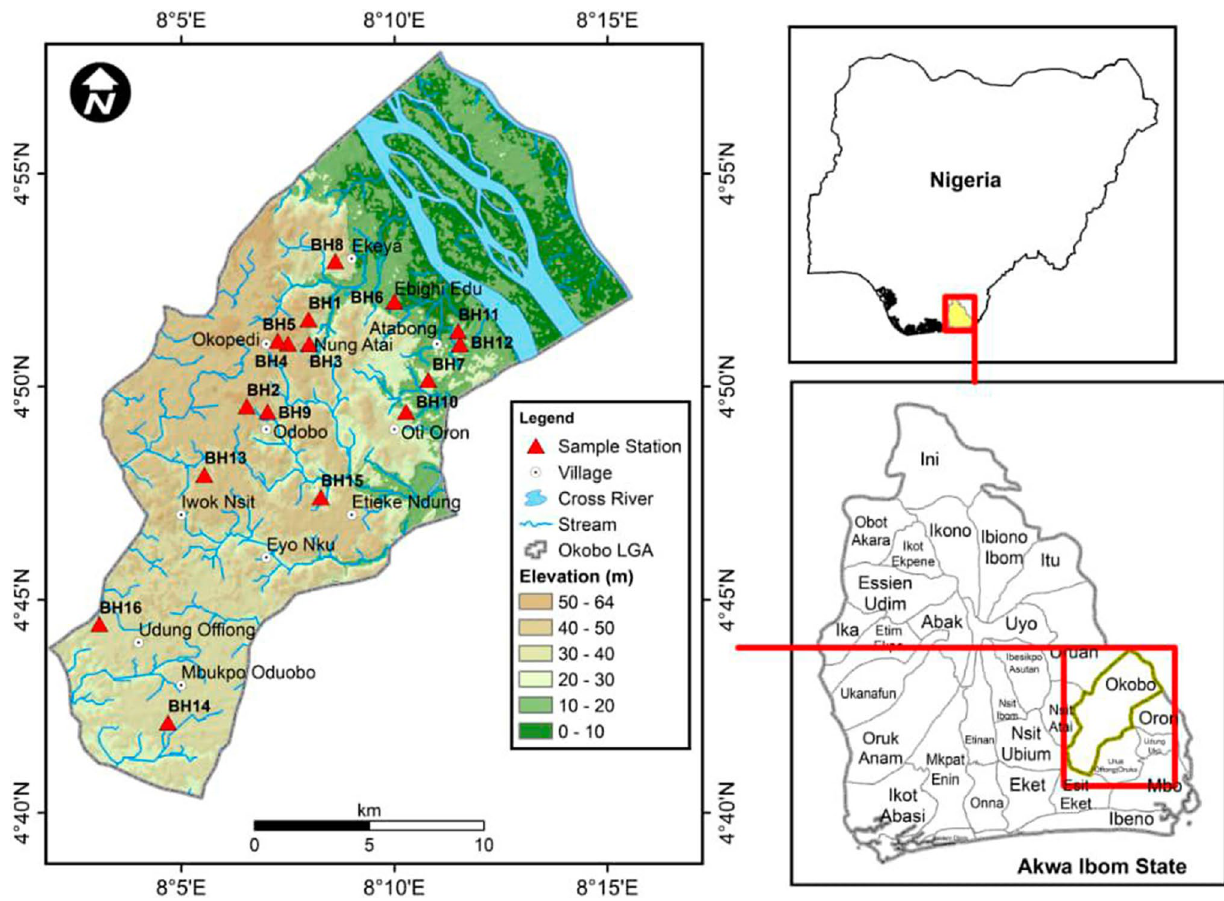
Fig. 1 Map of the study